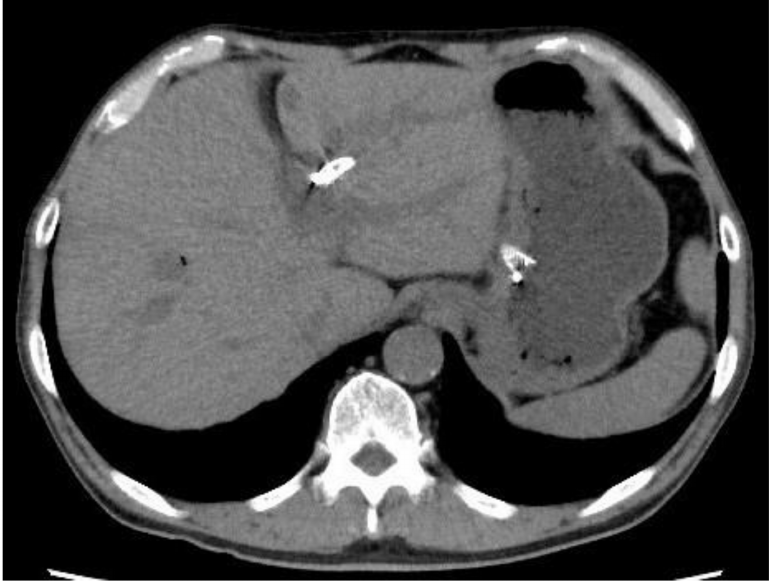
Figure 2. CT (Computed tomography) performed on the day after EUS-HGS revealed that the stomach stent was too